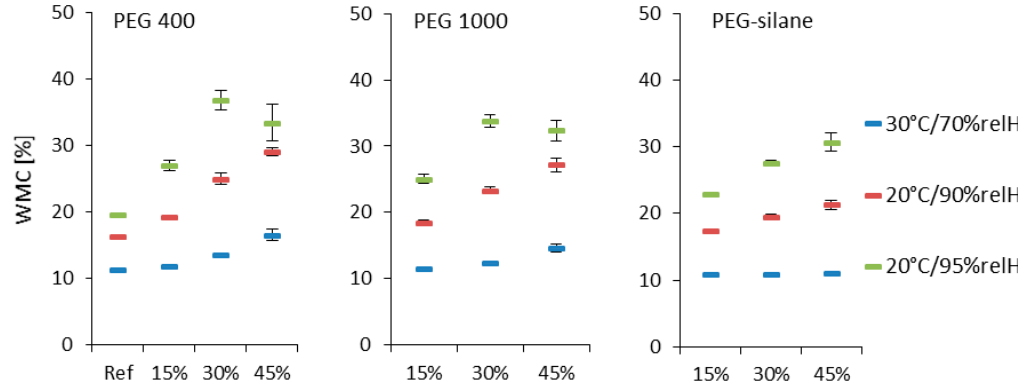
Figure 3. Wood moisture content (WMC) for different loaded oak wood in different climate conditions. Standard deviation given in whiskers. Different modification agent concentrations result in mostly statistically significant different WMC. Not significantly different are 15% concentrated PEG 400 and PEG 1000 compared to the reference, as well as 30% concentrated PEG silane to 15% and 45% concentrated PEG silane in 30 °C/70%relH.